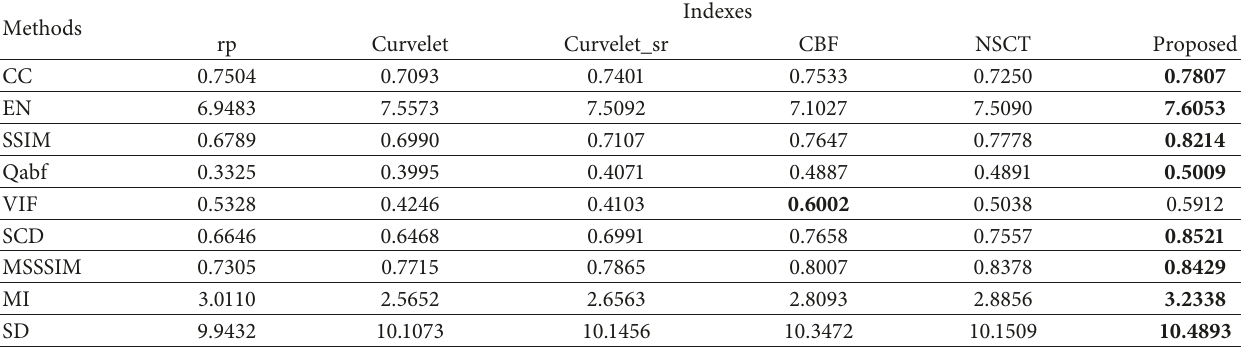
Table 2: Different fusion methods are compared quantitatively, and the best fusion results are highlighted in bold.